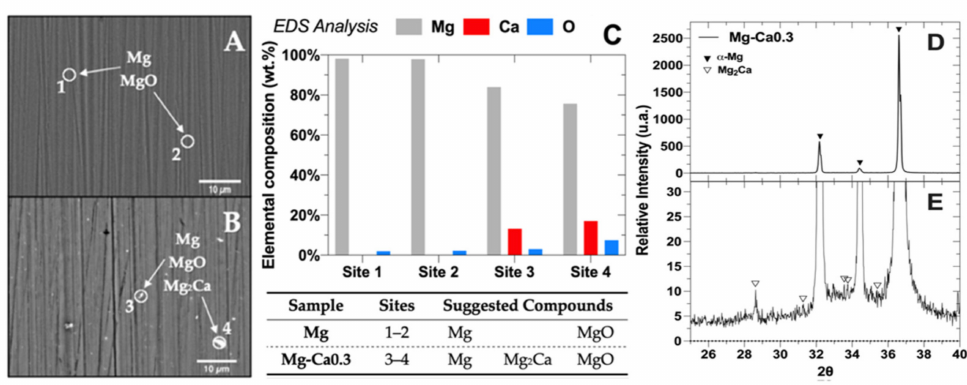
Figure 1. SEM images (2000 × ) of the Mg ( A ) and Mg-Ca0.3 ( B ) reference surfaces. ( C ) EDS analysis of sites marked on the SEM images and the suggested compounds. ( D ) XRD spectra of Mg-Ca0.3 alloy surface and ( E ) zoom of 2 θ region, presenting Mg 2 Ca